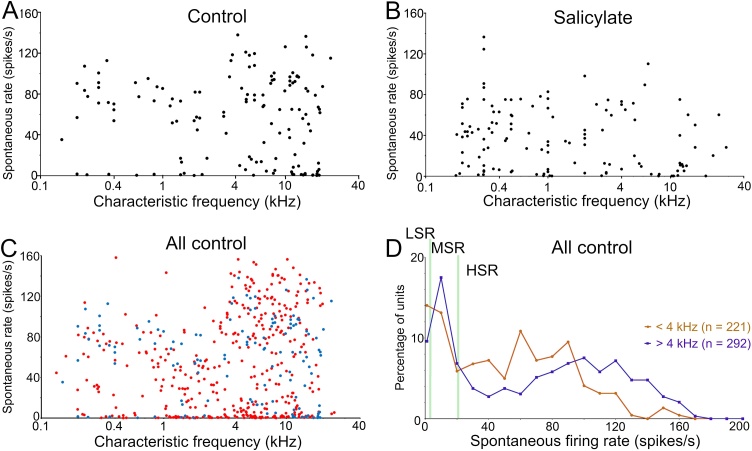
Scatter plots of CF versus spontaneous firing rate for the sample of fibres in the animals in the current control sample (A) and the salicylate sample (B). (C) Scatter plot of spontaneous firing rate against CF for 512 fibres from control groups of three previous studies (red dots; [[19], [20], [21]]) and the present one (blue dots). (D) Plot showing the percentage of units in a sequence of bins of mainly 10 spikes/s intervals for all 512 control fibres split into two groups based on their CF. The first two bins are different in that the first bin is for units with rates < 1 spikes/s and the second from 1 to 10 spikes/s. The pale green vertical lines mark the borders between the three subtypes of type I fibres.